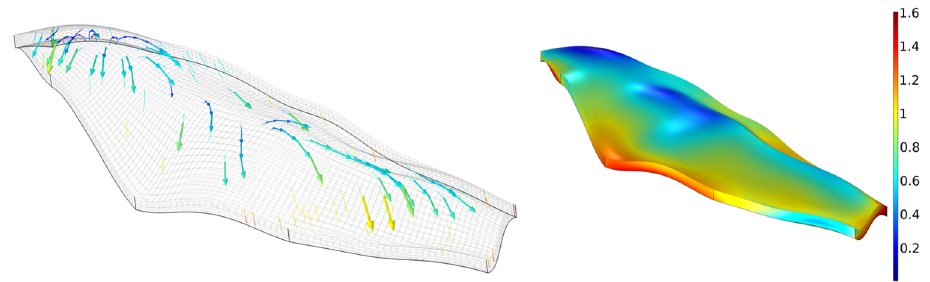
Figure 11. Steady flow field of non ‐ ore ‐ bearing layer.